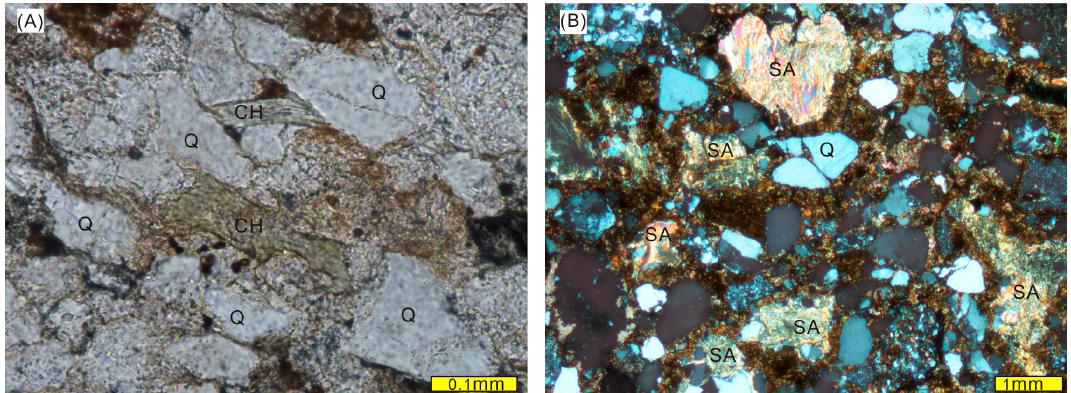
Figure 7. ( A ) Photomicrograph of a sandstone block from the MG mélange. Note that chlorite (CH) crystallized along boundaries among the quartz grains, possibly replacing matrix or cements. Finer epidote crystals also occur; ( B ) Photomicrograph of the volcaniclastic sandstone from subunits Tr mb . Note that the sample is rich in volcanic clasts that are intensively sericitized. CH—chlorite; SA—sericitized volcanic clast; Q—quartz.